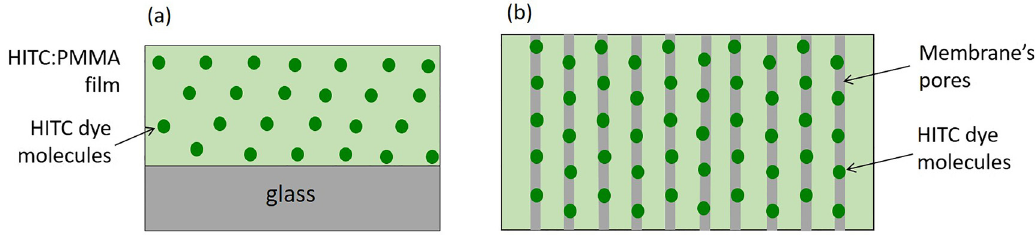
Figure 1: Schematics of experimental samples. (a) HITC:PMMA film deposited on glass and (b) anodic alumina membrane impregnated with dye-doped polymer (HITC:PMMA).